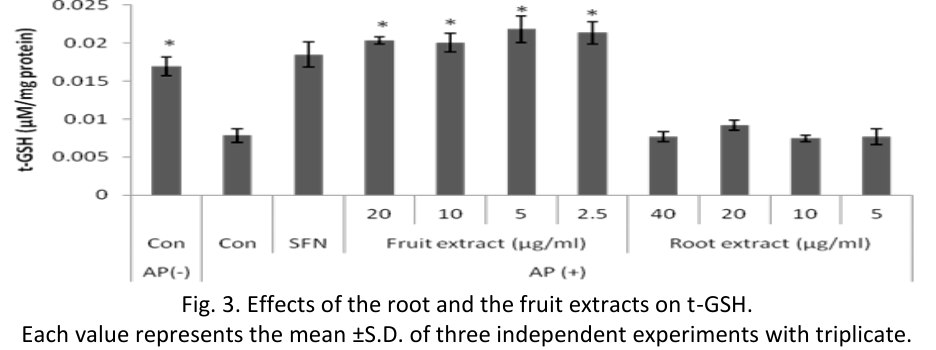
Fig. 3. Effects of the root and the fruit extracts on t-GSH. Each value represents the mean ±S.D. of three independent experiments with triplicate.